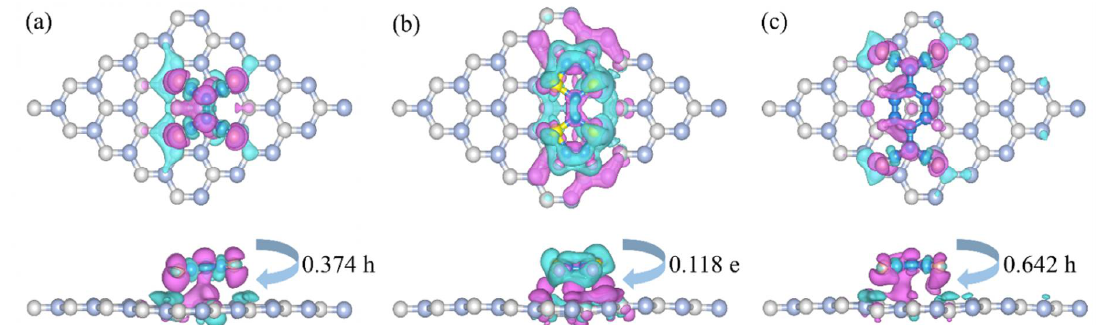
Figure 3. Charge difference density of organic molecules ( a ) TCNE, ( b ) TTF, and ( c ) TCNQ adsorbed on the g − ZnO. The iso − surface value is set to 0.0004 e Å − 3 . The purple and blue represent electron aggregation and electron dissipation, respectively.